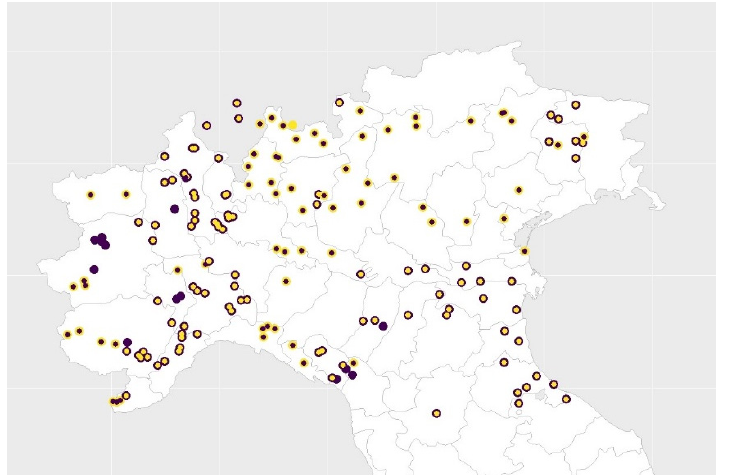
Figure 3. Gaps and dummies. Sample: Manzini and Savoia (2005) (187 datapoints). Key: no gap, no dummy; gaps, no dummy; gaps and dummies; no gap, dummies.